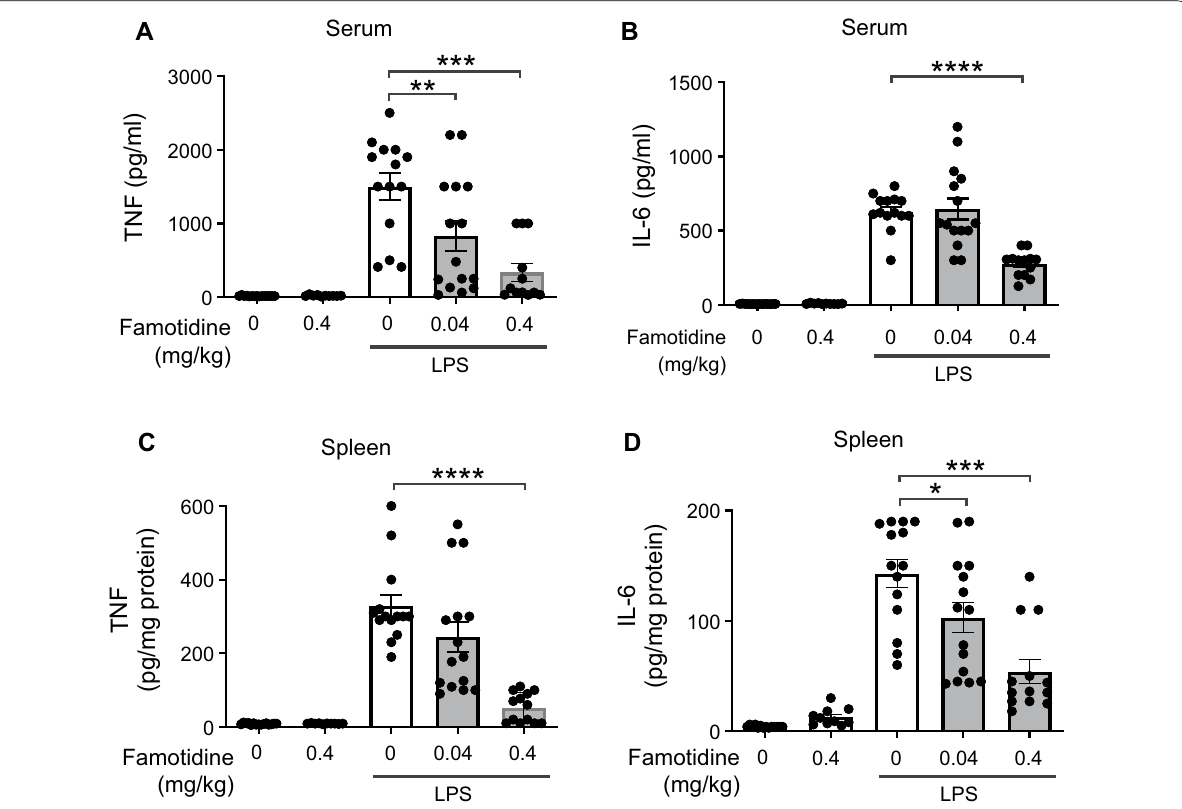
Fig. 2 Famotidine is more potent when administered into the central nervous system. A – D Famotidine (intracerebroventrical, ICV) injection attenuated LPS-induced systemic TNF and IL-6 release in mice. Male C57BL/6 mice had ICV injection of PBS or famotidine (0.04 or 0.4 mg/kg in 5 µl volume) 30 min before LPS. LPS was administered IP at 7 mg/kg. Mice were euthanized 2.5 h post-LPS injection and serum and spleen were harvested for analyses. N 5 for normal group. N 10 for FM alone. N 13 or 14 for other groups. *P < 0.05,. **P < 0.01.***P < 0.001, ****P < = = =